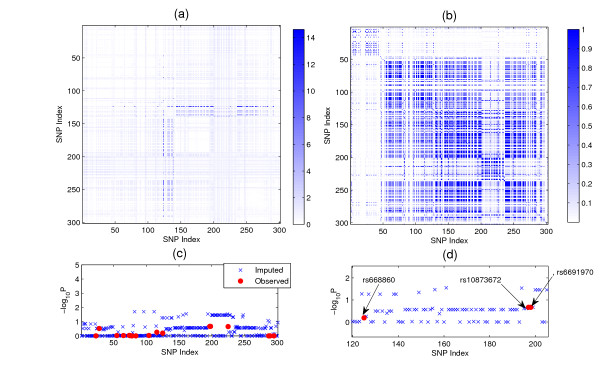
Analysis result of the local region of the BD data set located by rs668860, rs10873672 and rs6691970. (a) The enriched signal after imputation: The intensity shows -log10P given by the joint regression. (b) The LD structure of this local area. (c) The -log10P value obtained using single-SNP analysis. (d) The locations of rs668860, rs10873672 and rs6691970.